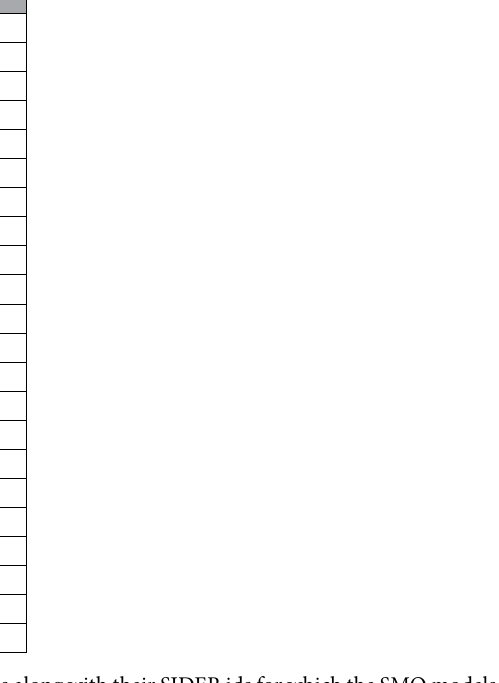
Table 2. Provides the list of the 22 neurological ADRs along with their SIDER ids for which the SMO models were